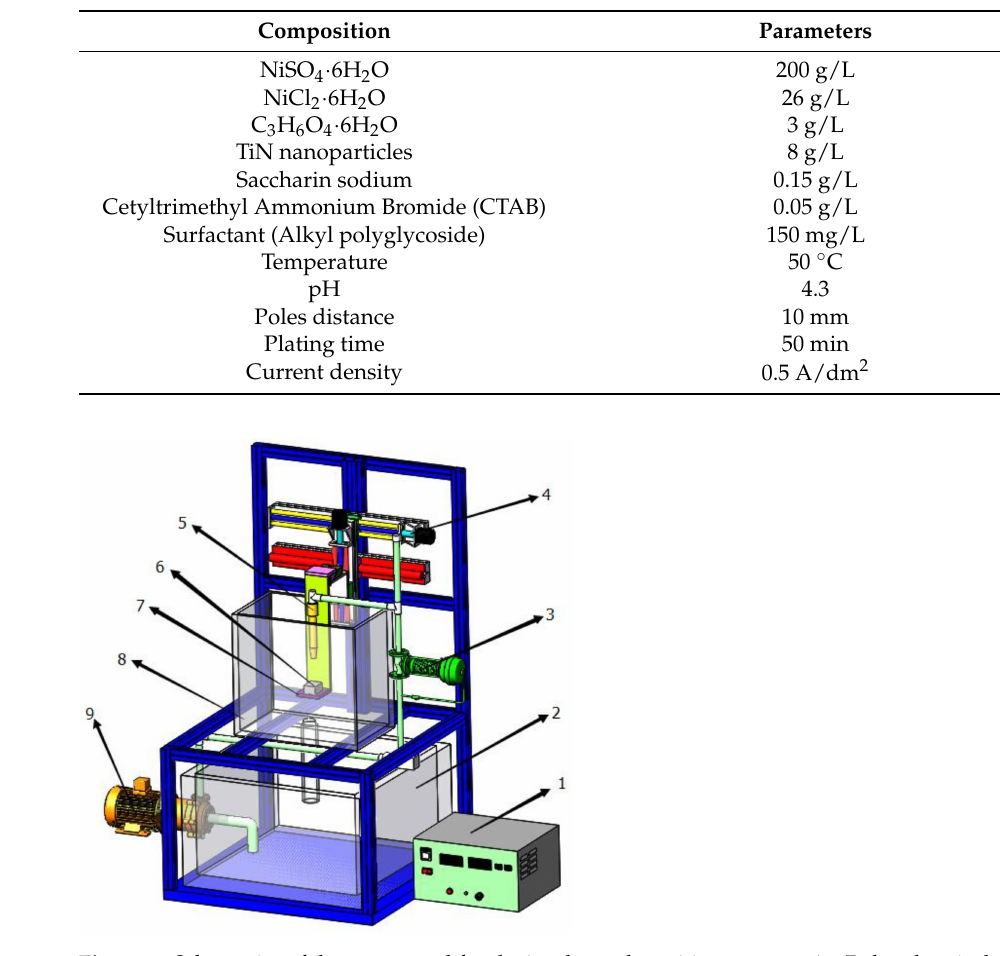
Figure 1. Schematics of the setup used for the jet electrodeposition process. 1—Pulse electrical source, 2—Electrolyte recovery, 3—Rotameter, 4—Servo system, 5—Nickel nozzle, 6—Specimen, 7—Platform, 8—Electrolytic cell, 9—Reciprocating